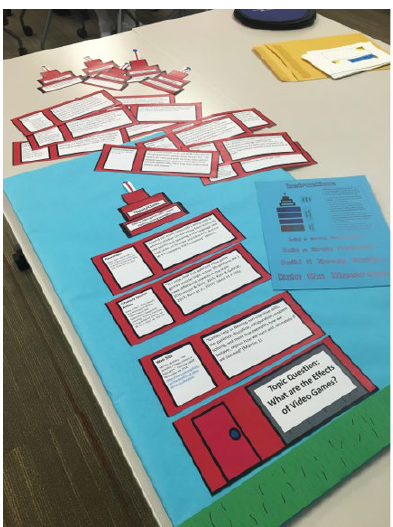
Argument-skyscraper designed by a team of students using a pre-written